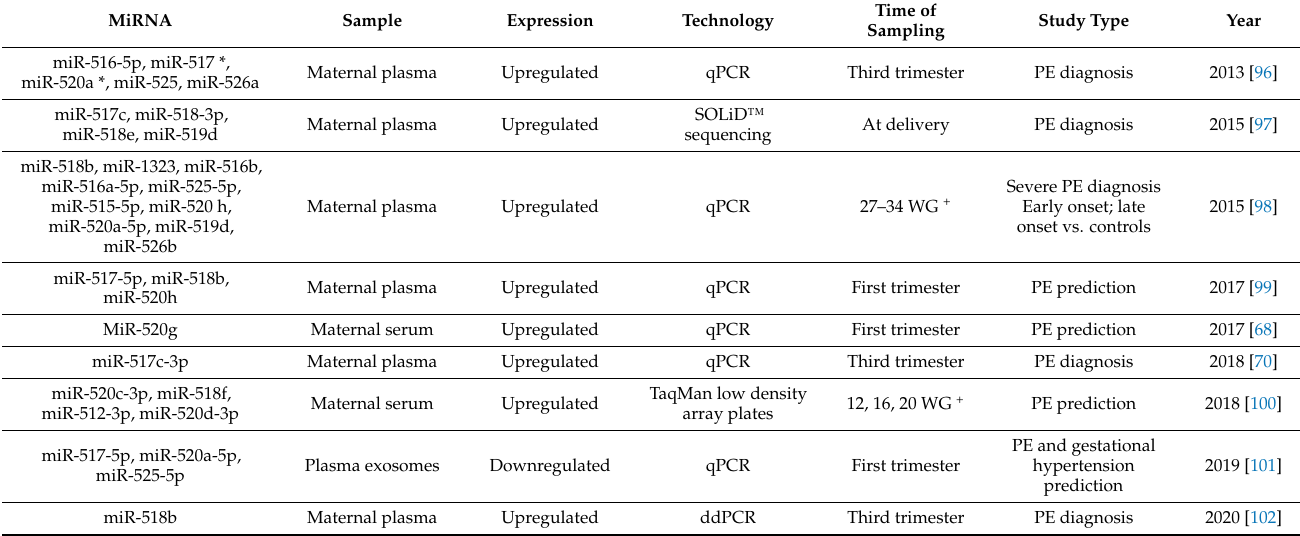
Table 1. C19MC miRNA differential expression in maternal circulation of PE